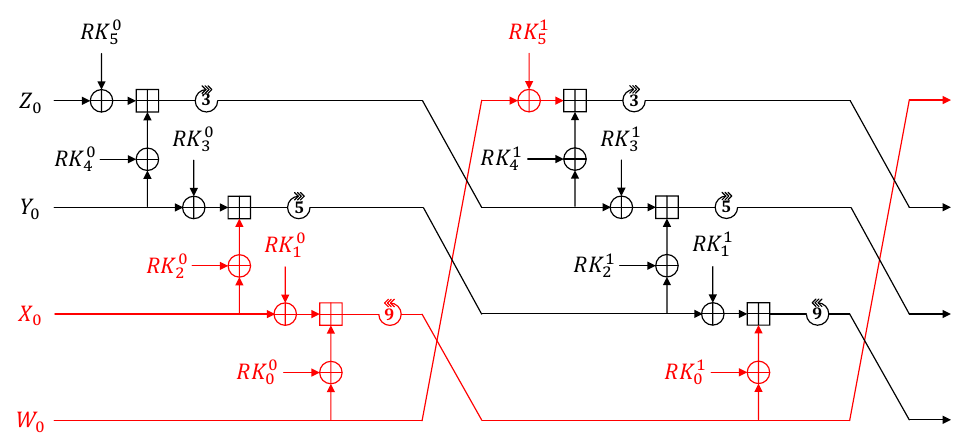
Figure 13. Rounds that can be efficiently progressed by a fixed nonce in LEA.